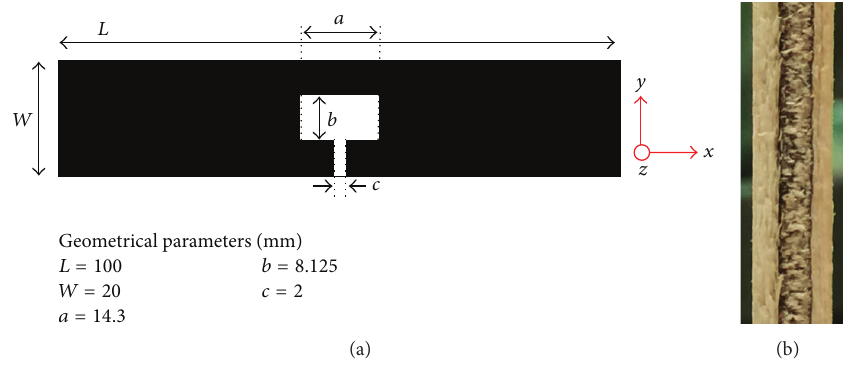
Figure 1: Studied tag antenna geometry (a) and cross section of the used plywood material (b).